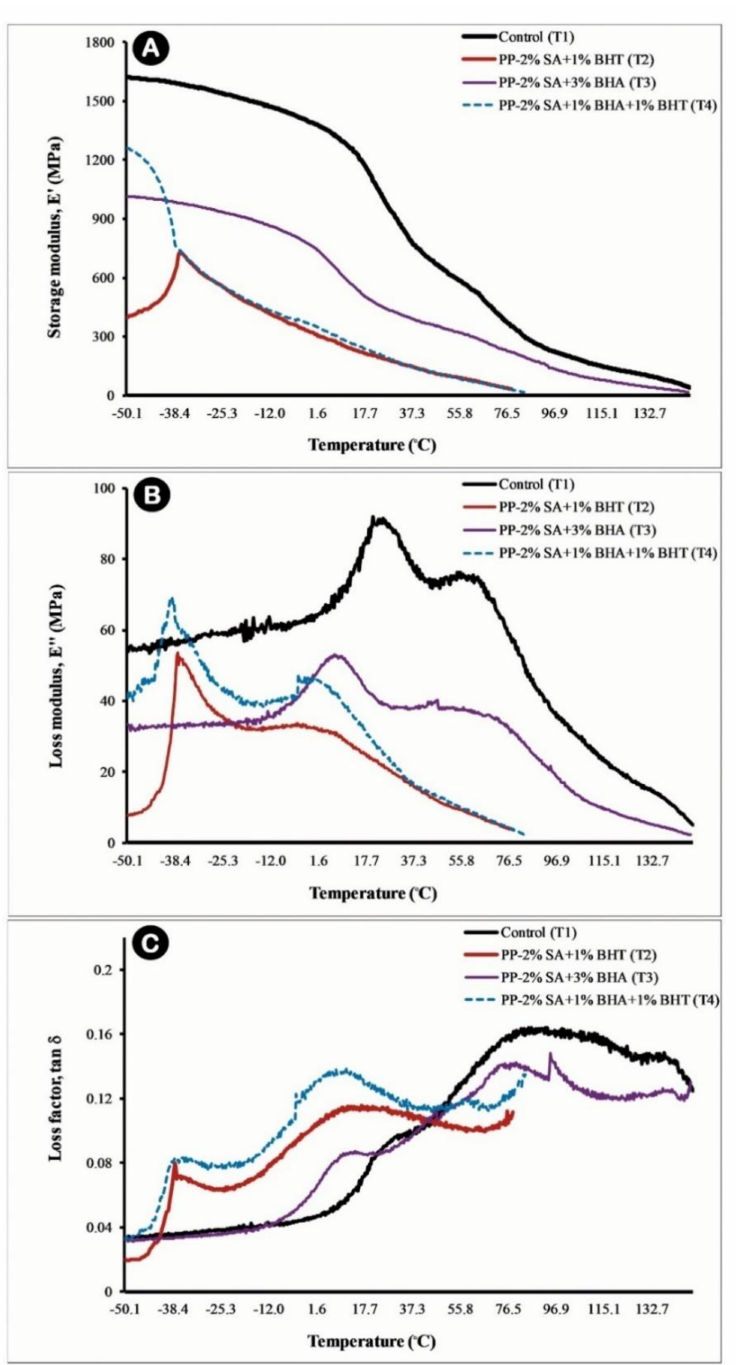
Figure 6. Viscoelastic behaviour for pure polypropylene (control, T 1 ) and different active composite films (T 2 –T 4 ) as measured by storage modulus, E (cid:48) ( A ); loss modulus, E” ( B ); and loss factor. tan δ , ( C